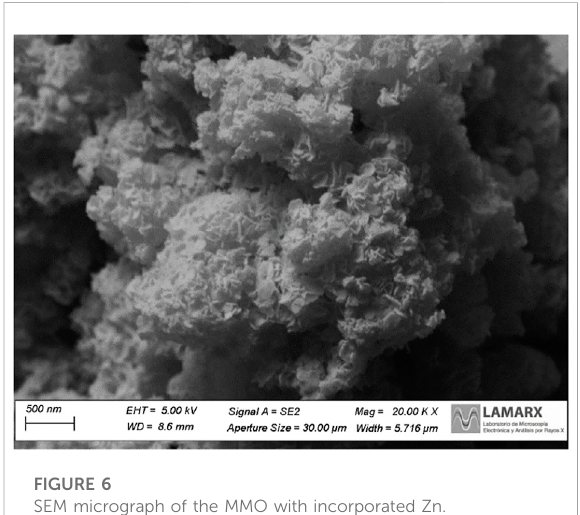
FIGURE 6 SEM micrograph of the MMO with incorporated Zn.